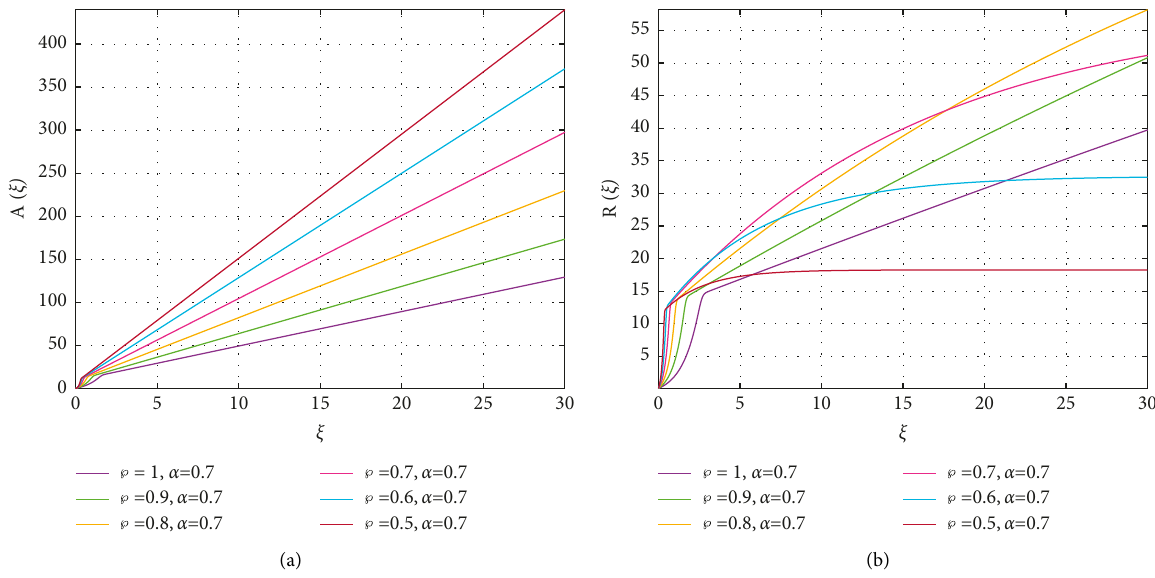
Figure 8: (a) Displays of addicted individuals S ( ζ ) (b) Displays of recovered individuals E ( ζ ) using a Newton polynomial approach for decreasing fractal-dimension ℘ and fixed α � 0 . 7.